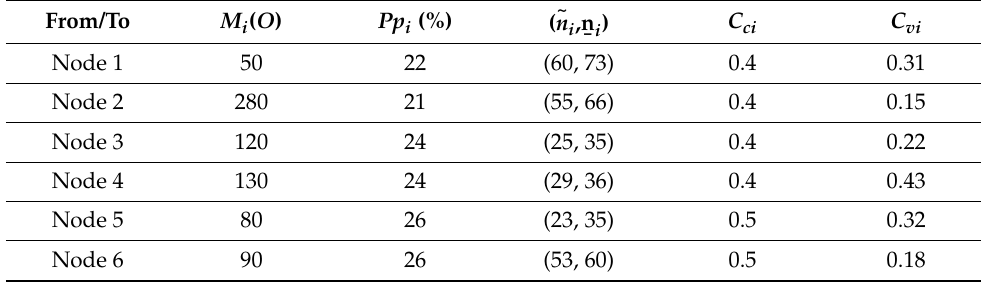
Table 7. Specific parameters of entities in Topology